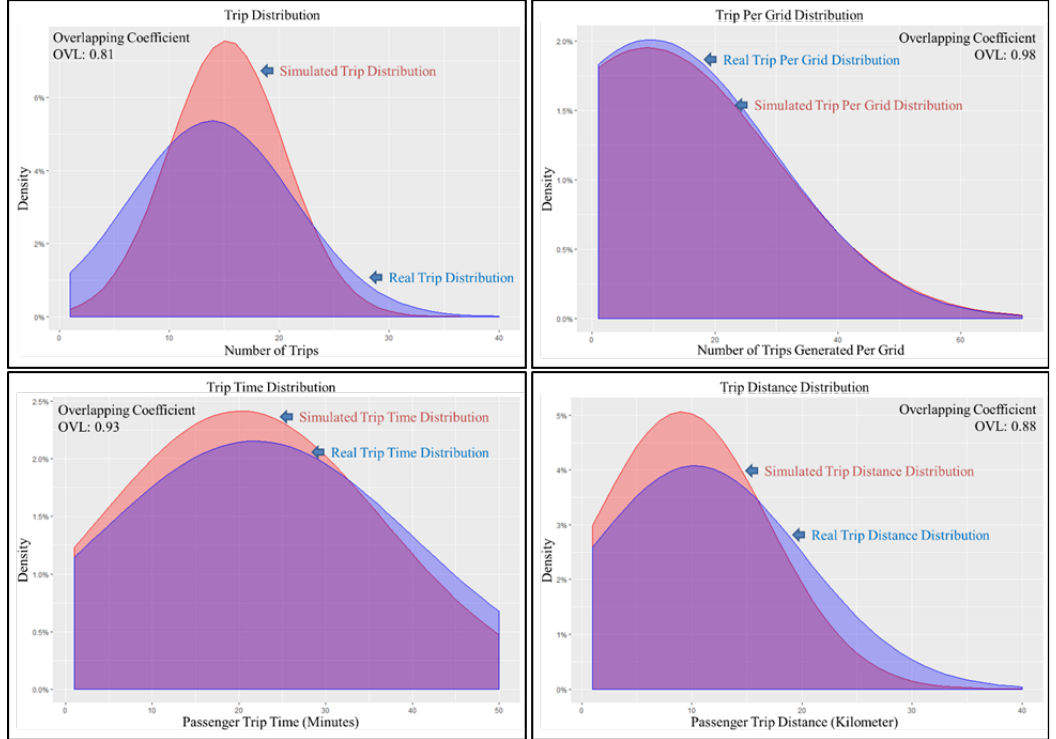
Figure 17. Simulated trip vs real trip regarding distribution (day type = weekday). Table 3. Weekday simulated trip data vs real trip data comparison.